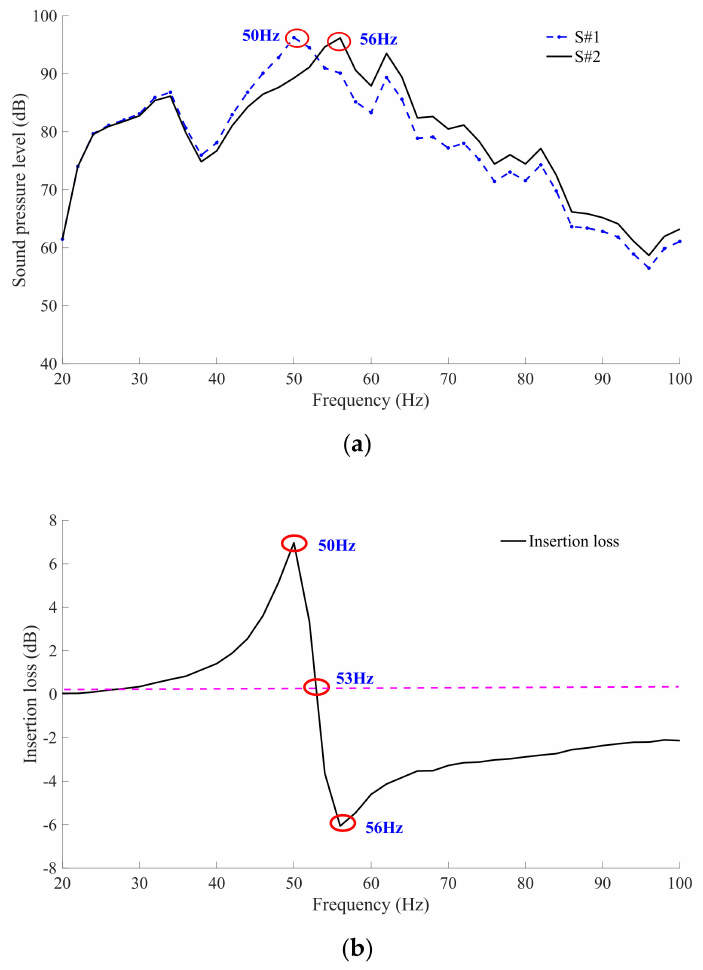
Figure 9. Sound pressure level and insertion loss at field point 1; ( a ) sound pressure level; ( b ) inser- tion